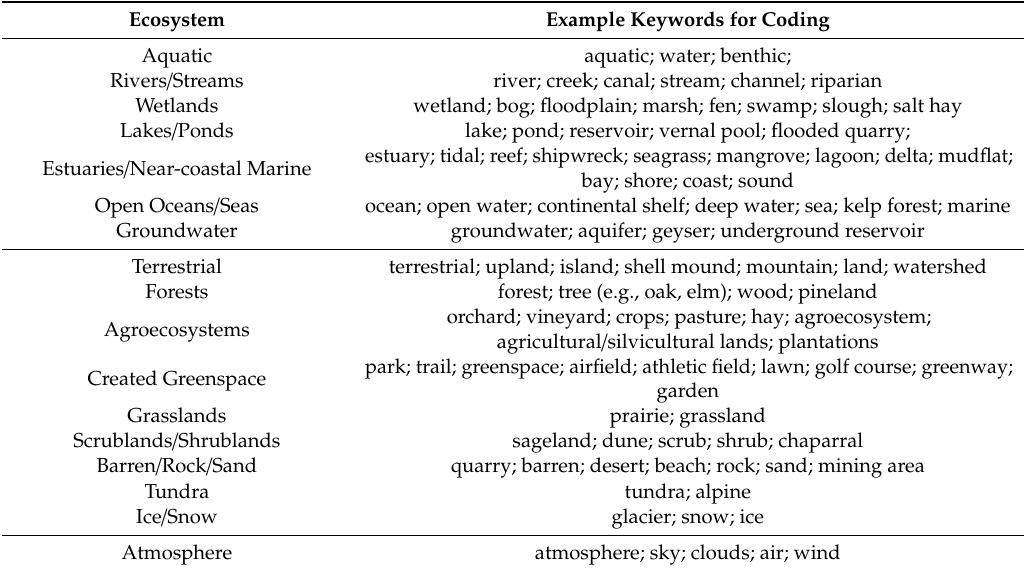
Table 4. Example keywords used to code each sub-class of ecosystem (full list in Supplementary Table S1).